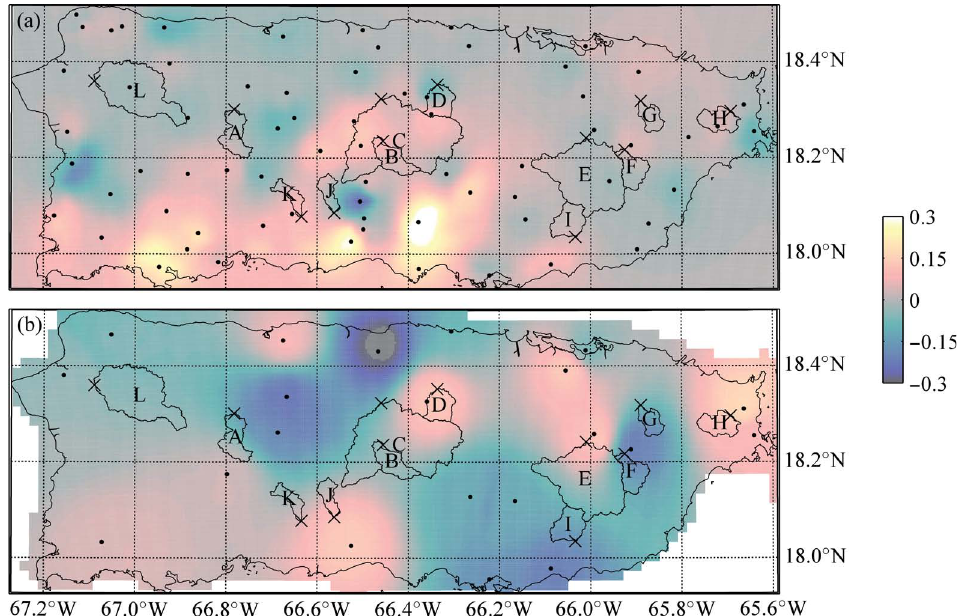
Fig. 4. The trend [%yr − 1 ] from 1955 to 2010 for annual mean (a) P and (b) PET. Significant as well as insignificant trends are shown. The points mark stations with > 20yr time series of (a) P , and (b) T min and T max (used to derive PET, see Sect. 4.2). Catchments identified by letters and stream gauges by crosses. Table 5. Cumulative change in the difference between observed and simulated Q characteristics, as expressed by ˆ A (Eq. 5 [%]), and corre- sponding standard errors ( ˆ σ ˆ ; Eq. 9) for the 12 study catchments. The + and − signs indicate, respectively, increases and decreases in ˆ A . A The change covers the start of the record (cf. Table 1) until